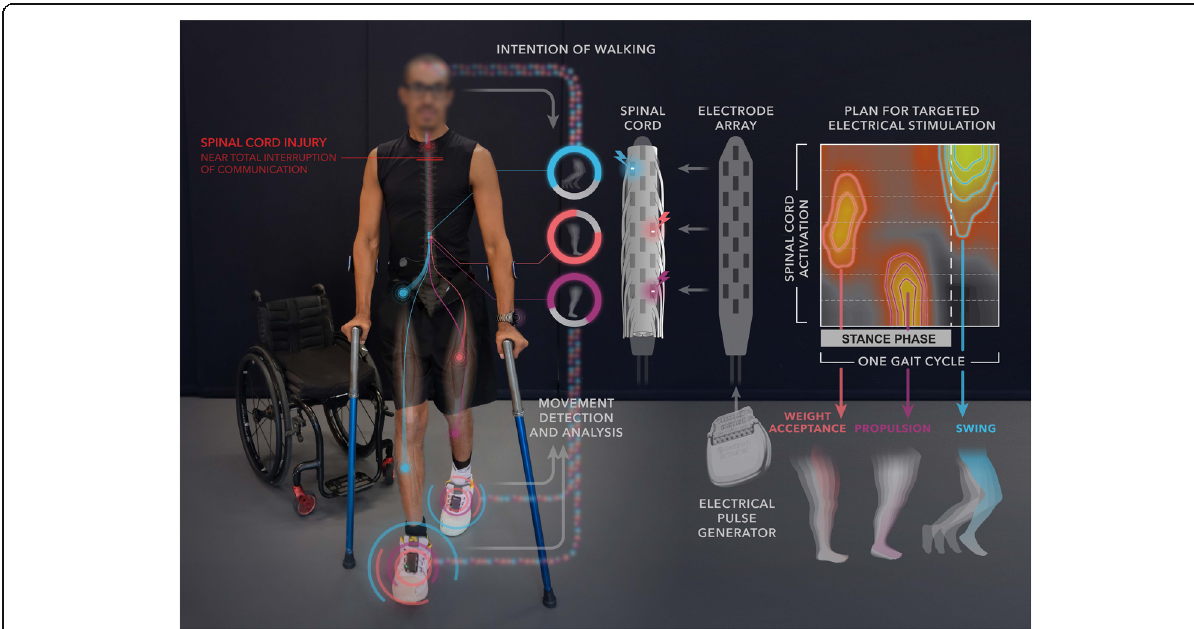
Fig. 3 Spatiotemporal EES reproduces the natural activation of the spinal cord. Delivery of EES bursts matching the spatial and temporal dynamics of natural motor neuron activation immediately enables locomotion after SCI. Decoding algorithms detect foot movements in order to adjust the location and timing of the spatiotemporal stimulation sequences to the current needs of the patient. The spinal cord activation map is reconstructed based on the projection of electromyographic recordings onto the theoretical location of motor neurons in the spinal